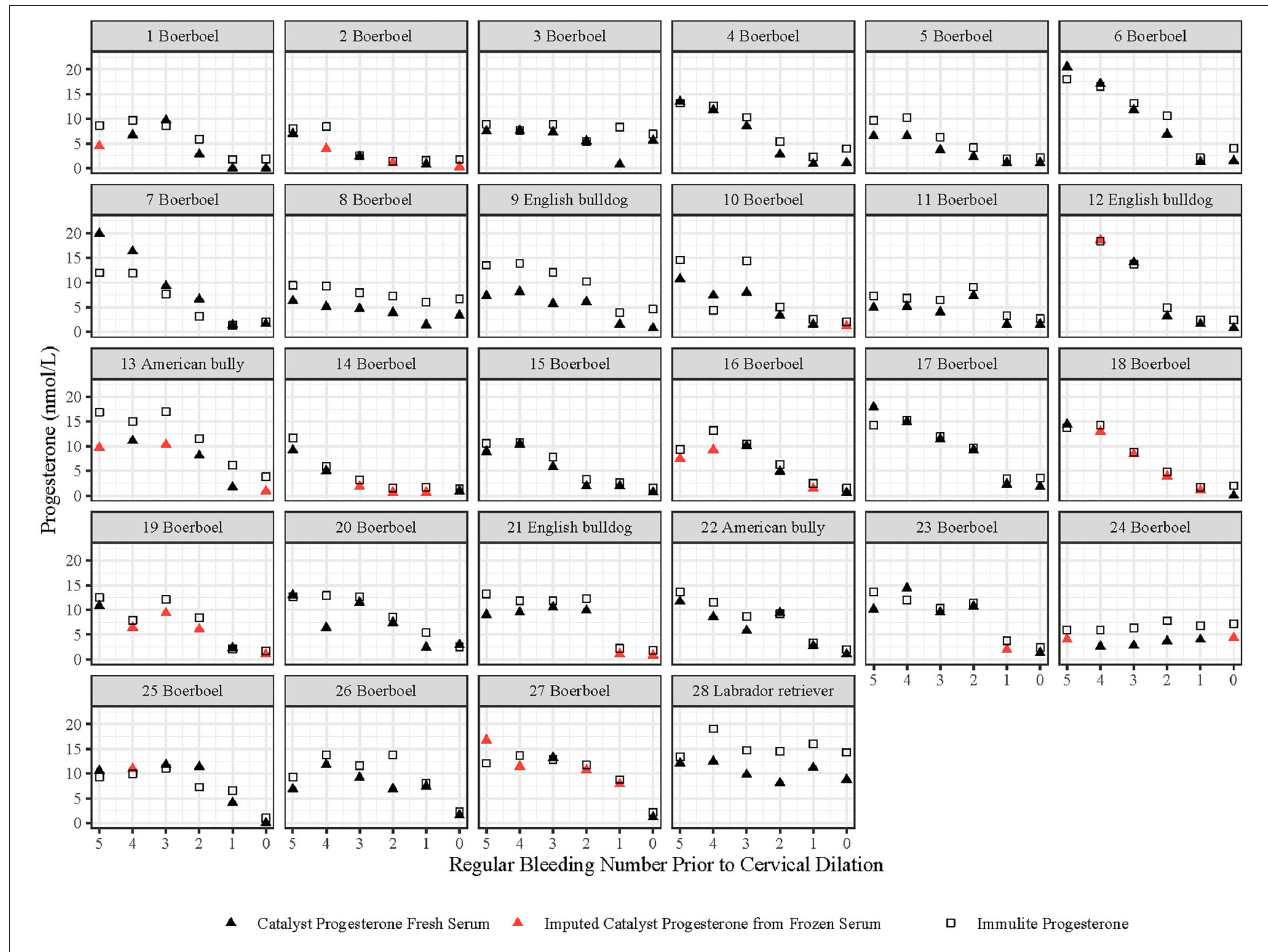
FIGURE 1 | Serum progesterone levels measured with the Catalyst and IMMULITE assays in 28 bitches before and at the first detected time of cervical dilatation (TCD, shown as time zero). Time 1–5 represent the regularly scheduled bleeding times at 0800h and 1800h that occurred before TCD. Time 1 could occur 0–14h before time zero.